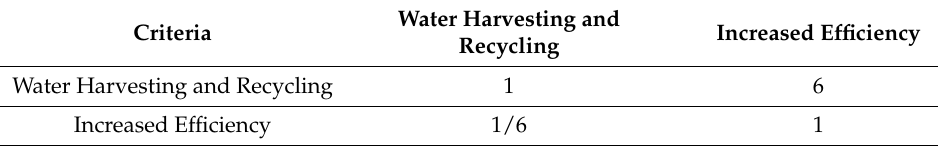
Table 4. Paired comparison matrix for the water efficiency (WE)